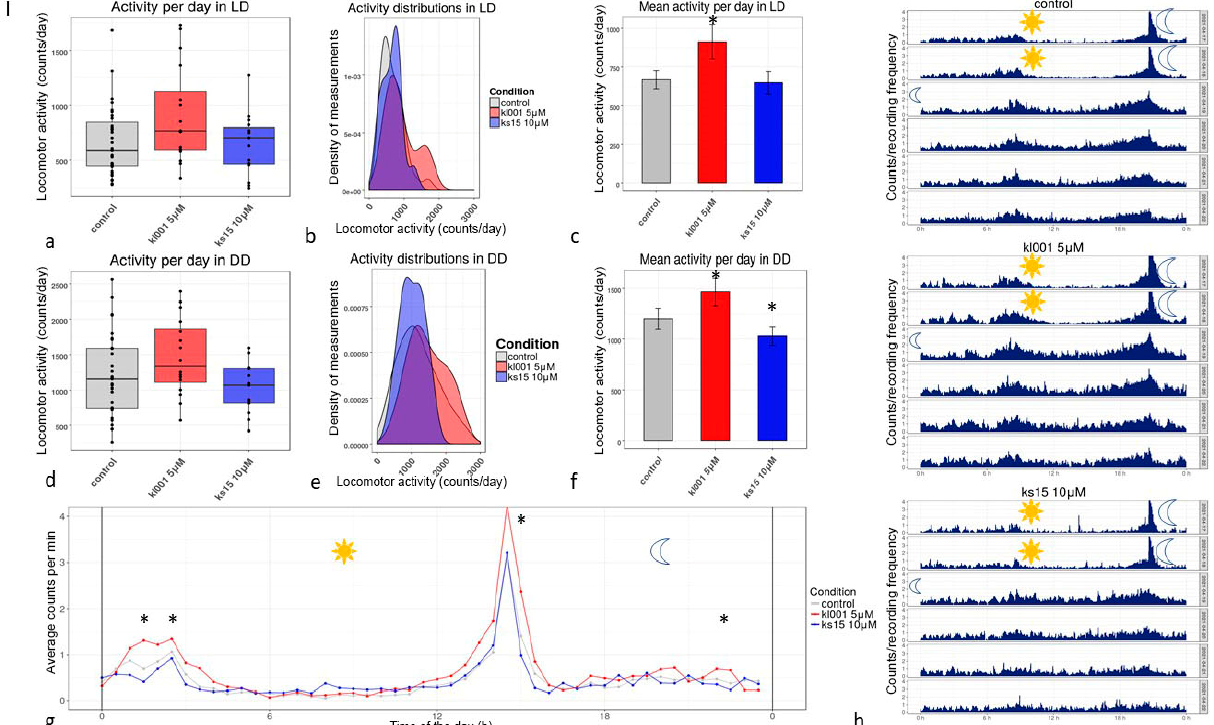
Figure 1. The locomotor activity profiles measured for CS males treated with lifespan modifying doses of KL001 и KS15 until the age of 5–12 days: ( a , d )—activity per day in LD and DD; ( b , e )—activity distributions in LD and DD; ( c , f )—mean activities in LD and DD; ( g )—profile of locomotor activity in LD, measured as an average per minute; ( h )—actograms, presenting and comparing all the profile during six days of test, first to lines are LD, last four—DD in all three blocks; *— p < 0.0001 significant results, according to ANOVA with Tukey/Kramer procedure, p < 0.01 with Scheffe’s procedure for KS15 ( c , f ); *— p < 0.05, Mann-Whitney test for control vs. KL001 comparison. The effect on locomotor activity was observed both in LD and DD for KL001 cohort and for KS15 in DD, the daily activity profile in LD was elevated by KL001 5 µM solution in young age.